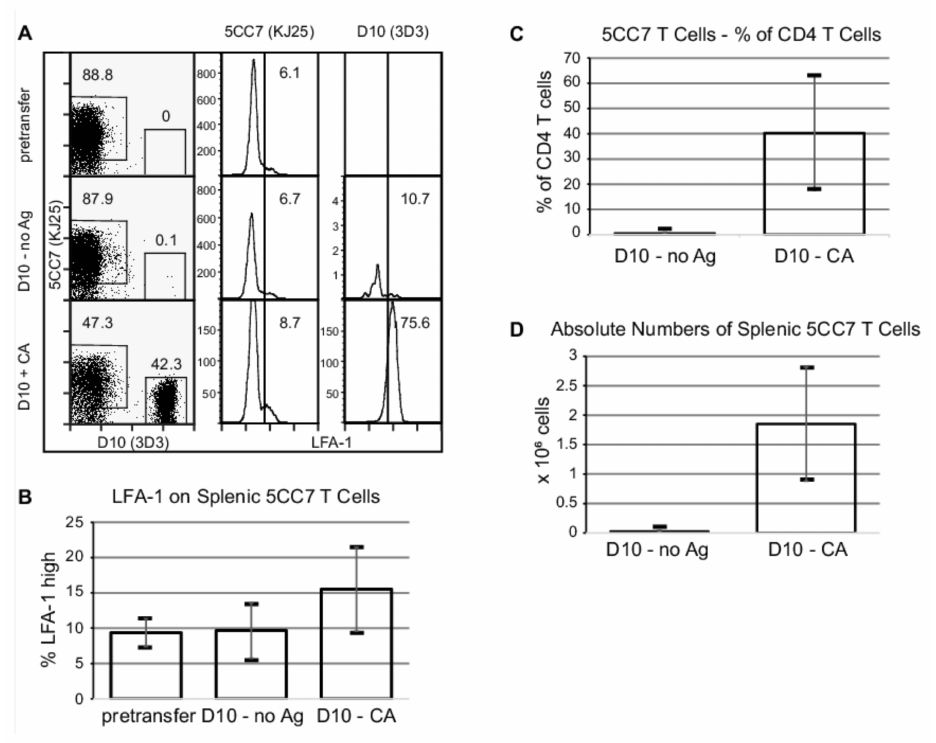
Figure 3. Immunization results in a robust expansion of expansion and activation of CA-specific T cells. 5CC7 RAG − / − mice were infected with PCC-BCG. At five weeks of infection, mice were transferred with spleen cells from D10 RAG − / − mice. The next day, mice were immunized subcu- taneously with CA or PBS as a control. One week after immunization, spleen cells were isolated and stained for flow cytometry. ( A ), Left panel is gated on CD4 + lymphocytes. KJ25 (middle) and 3D3 (right) panels were gated as shown in the left panel and numbers represent percent of gated cells expressing high levels of LFA-1. ( B ), Quantification of the number of splenic 5CC7 T cells that show high levels of the activation marker LFA-1. ( C ), Expansion of the D10 T cells quantified as % of CD4 T cell compartment. ( D ), Expansion of D10 T cells quantified as absolute numbers. In panels B–D, bars represent mean and error bars represent standard deviation. Data is representative of three independent experiments with 2–4 mice per